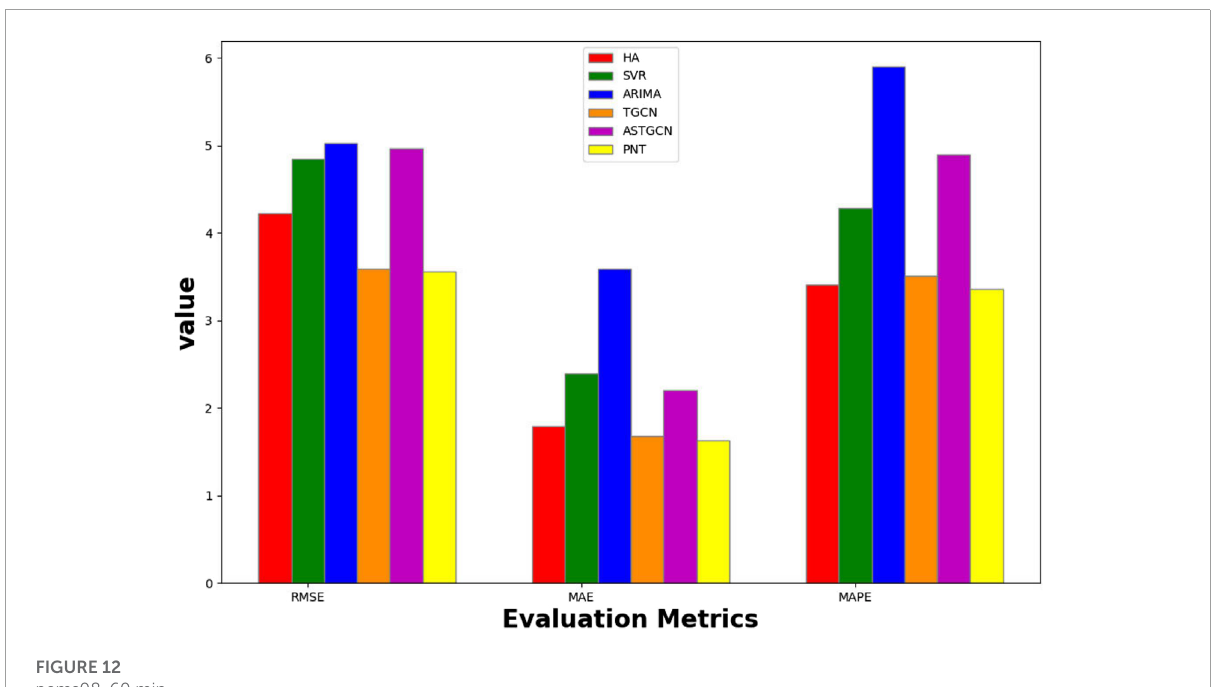
FIGURE 12 pems08-60